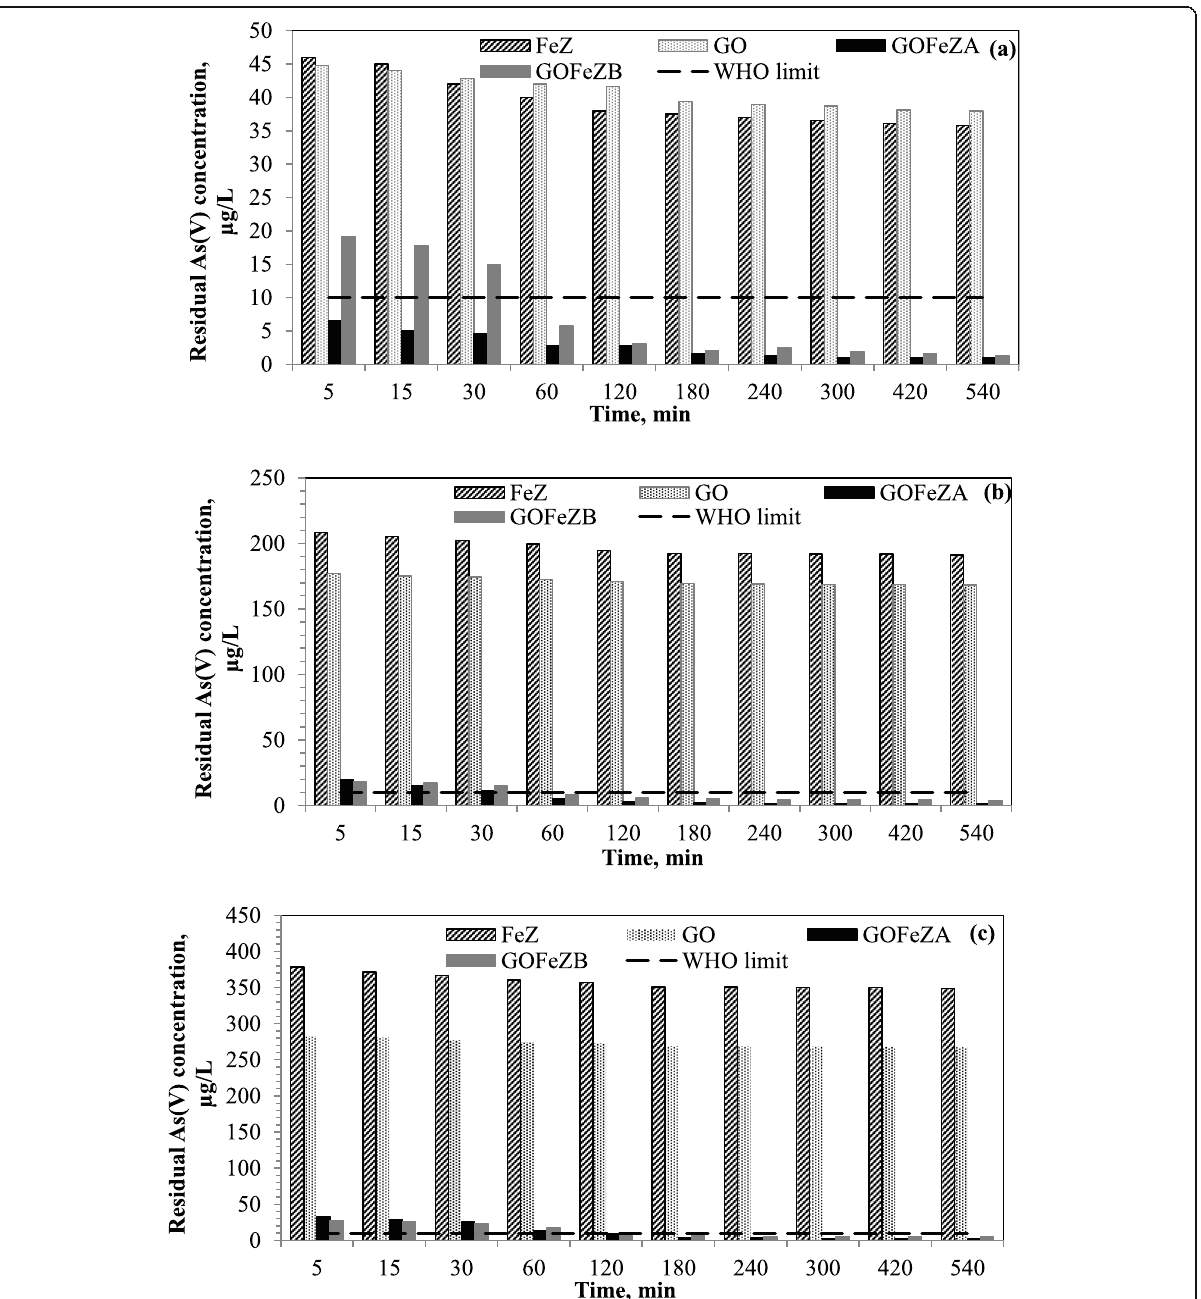
Fig. 5 Effects of initial arsenate concentration of a 50 μ g/L, b 250 μ g/L, and c 450 μ g/L on the residual arsenate concentration for FeZ, GO, GOFeZA, and